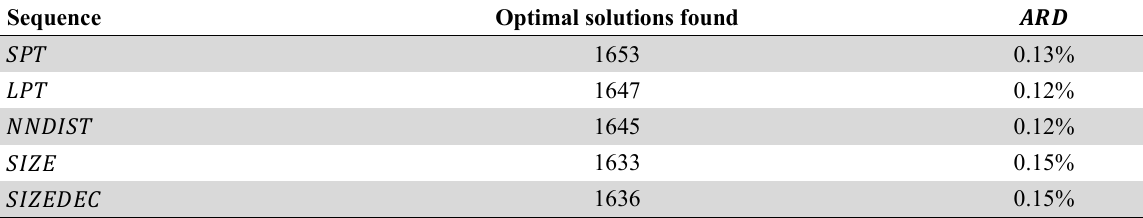
results for 𝒏 = 𝟓 , sorted by initial sequence 𝑰𝑮 𝑻𝑻𝑵 Sequence Optimal solutions found